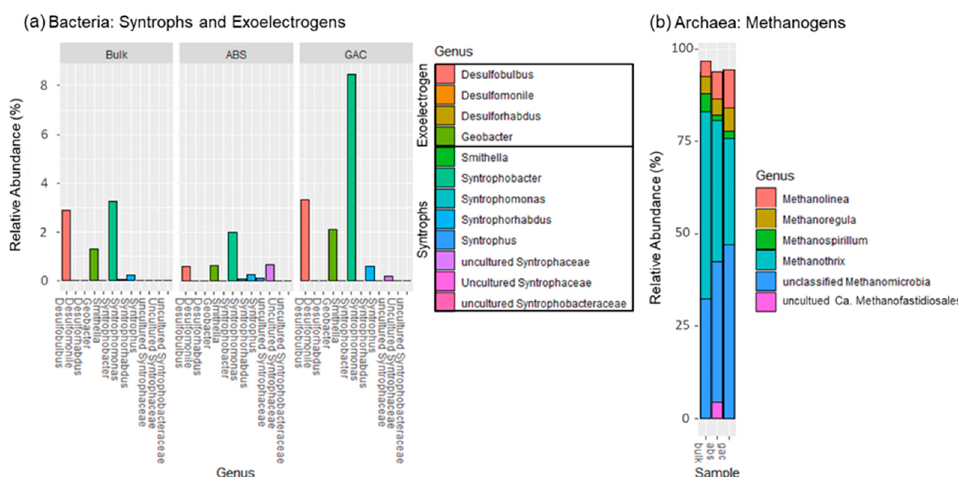
Figure 6. Microbial compositions illustrated in relative abundance at the genus level. Panel ( a ) shows the propionate-degrading syntrophic bacteria and exoelectrogens. Panel ( b ) shows the archaeal communities; non-methanogenic archaea are excluded.